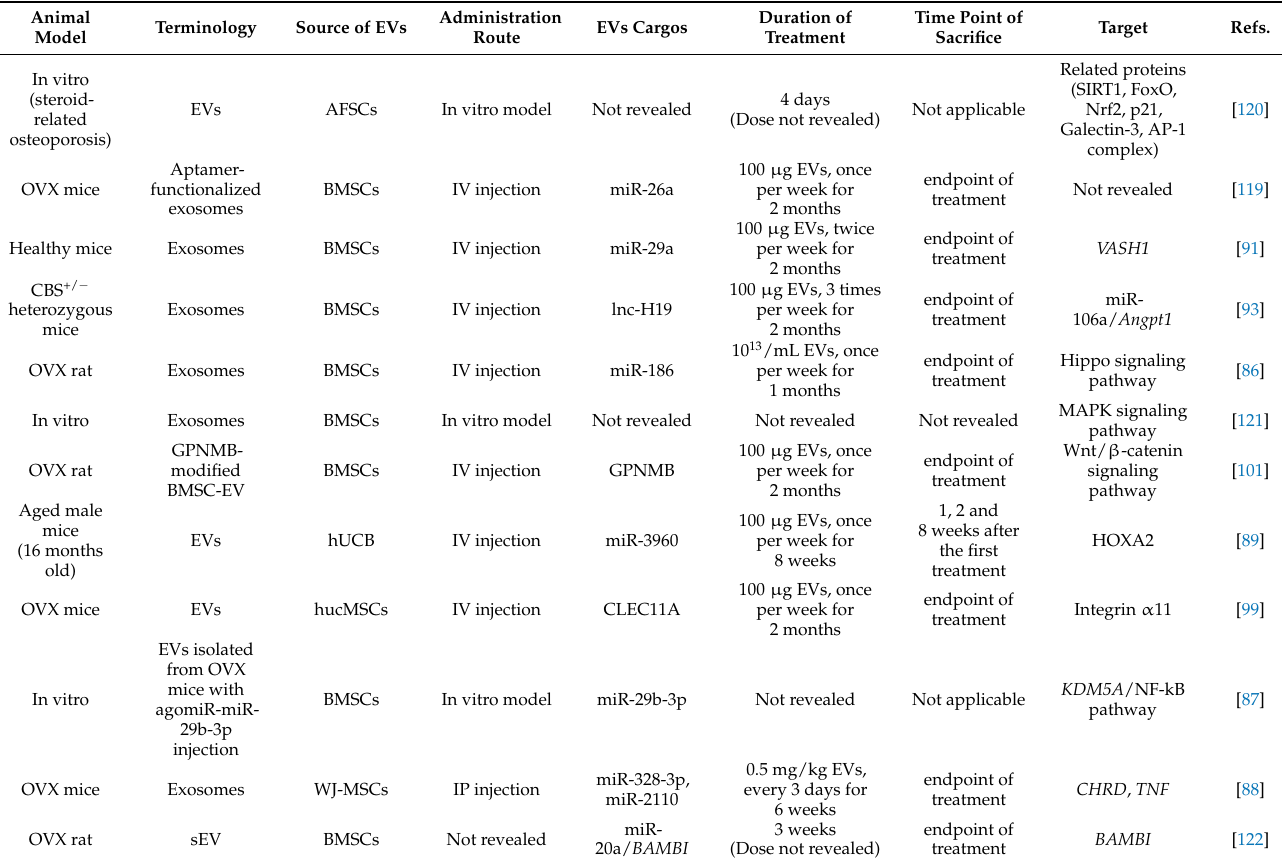
Table 2. A summary of in vitro and in vivo studies of exogenous MSC-EVs for treating osteoporosis. Animal